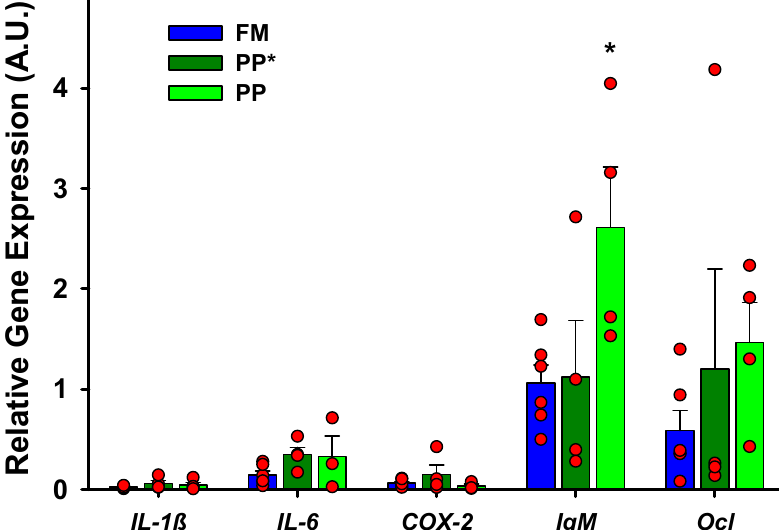
Figure 4. Intestinal basal gene expression of fish exposed to long (PP) or short term (PP*) diet in Phase II (250 g). The relative gene expression (A.U.) of the different genes is expressed by the mean and standard error. An asterisk on the bars indicates significant differences ( p < 0.05). Sample data in each experimental group are represented by red spots.